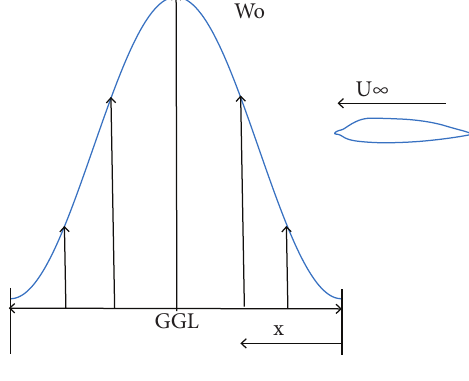
Figure 5. Discrete 1-cos